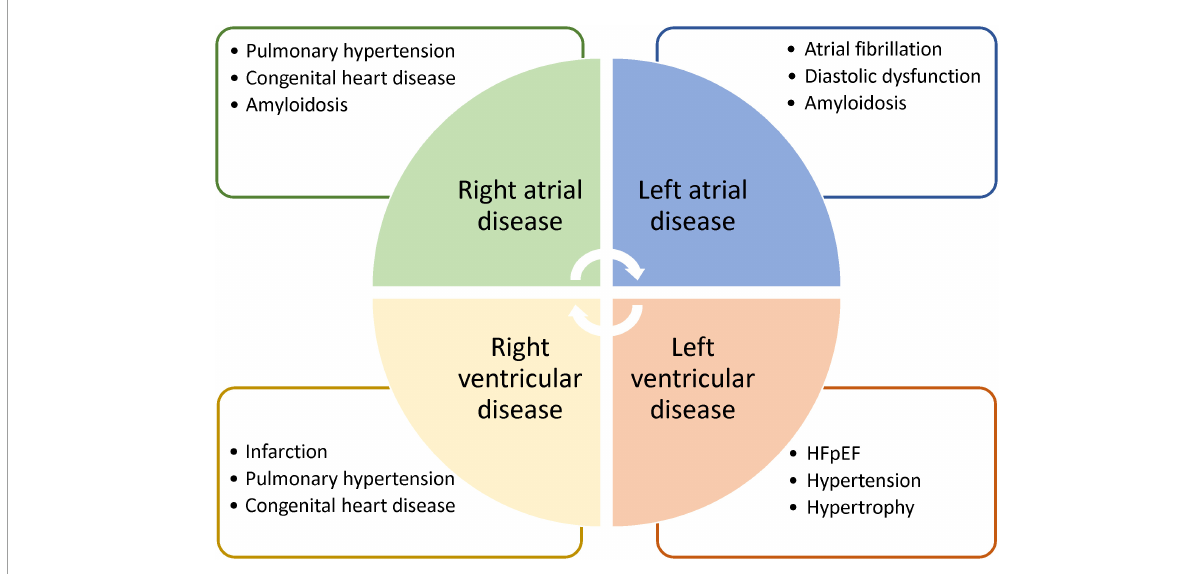
FIGURE5 Potential applications of strain cardiac MRI. Strain MRI is suggested for deeper phenotyping of diseases affecting different heart chambers. Note that each list is intended to highlight potential applications and may contain diseases that are not exclusive to a particular chamber.